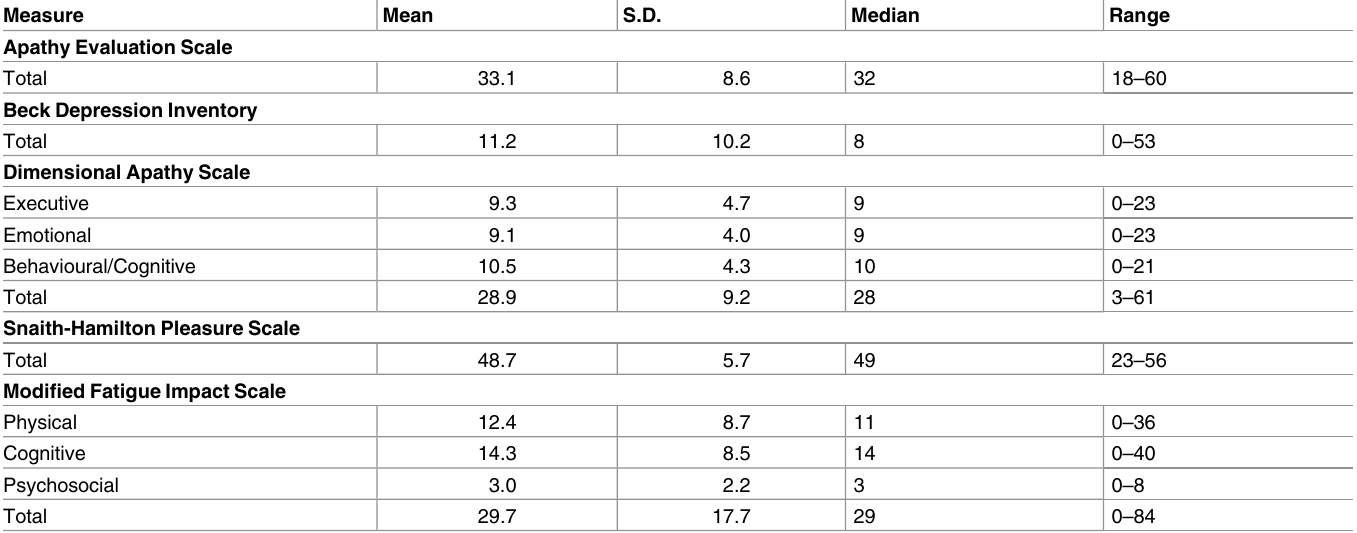
Table 3. Descriptivestatistics of related